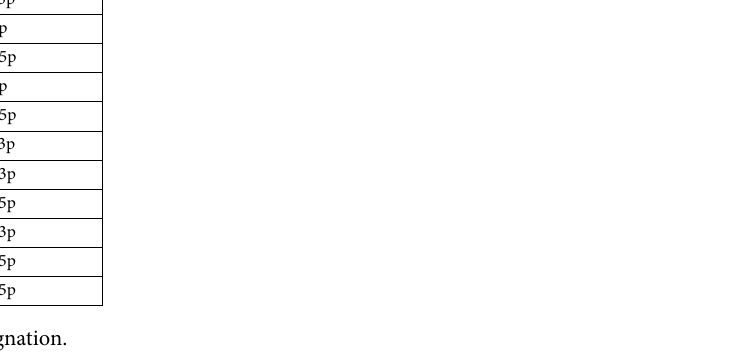
Table 1. microRNA